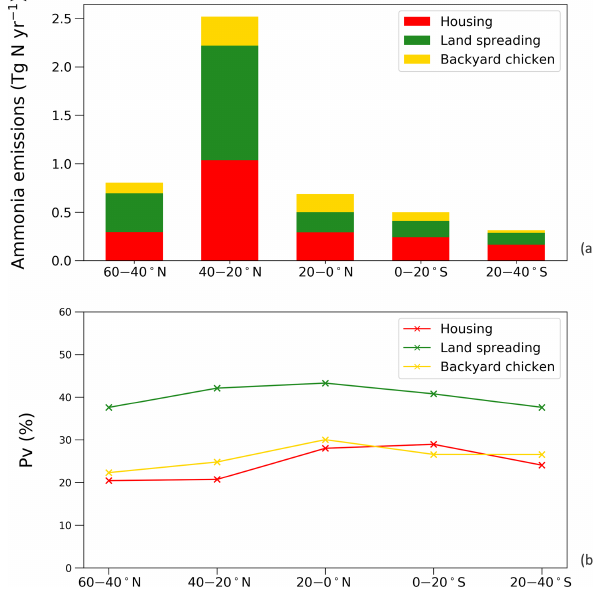
Figure 12. Simulated (a) annual global NH 3 emissions (GgNyr − 1 ) from chicken agriculture in 2010. (b) Percentage of excreted nitro- gen that volatilizes ( P V ) as NH 3 from chicken agriculture in 2010. The resolution is 0 . 5 ◦ × 0 . 5 ◦ .